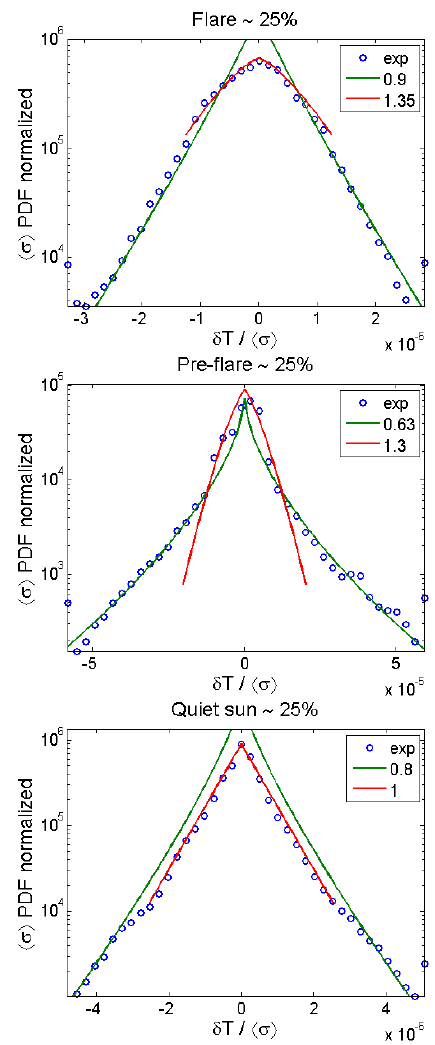
Figure 12. Stretched-exponential fits of the temperature fluctuation PDFs when energy content in small scales is 25%; µ values are given in the legends. (a) Flare ( µ = 0.9, β = 6.3 × 10 5 and µ = 1.35, β = 9 × 10 4 ), (b) pre-flare ( µ = 0.63, β = 2.8 × 10 3 and µ = 1.3, β = 1.5 × 10 8 ) and (c) quiet Sun ( µ = 0.8, β = 1.5 × 10 5 and µ = 1, β = 1.7 × 10 6 ).